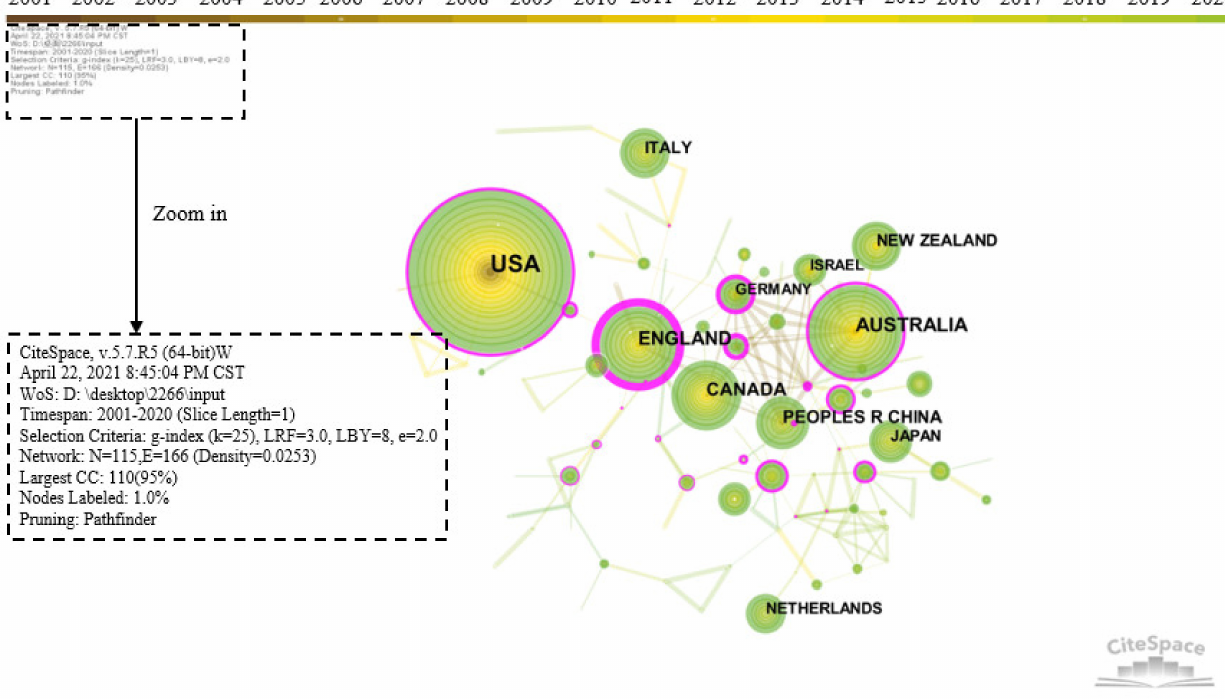
Figure 4. Visualization map of countries/regions cooperation network in the community resilience research from 2001 to 2020. Note that the size of the circle refers to the number of publications. The lines between the circles indicate cooperative relationship and the thickness indicates the strength of links between the countries/regions. The thickness of the outer pink circle represents the size of